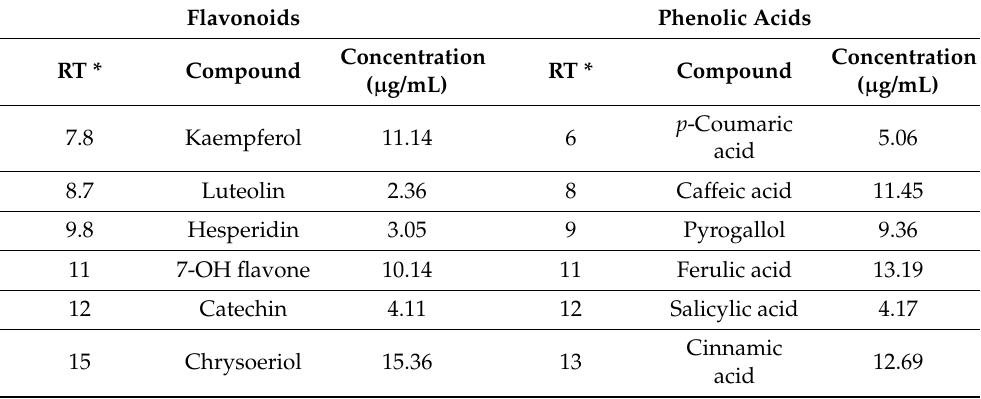
Table 2. Flavonoids and phenolic acids contained in M. pulegium extract, identified by HPLC. Flavonoids